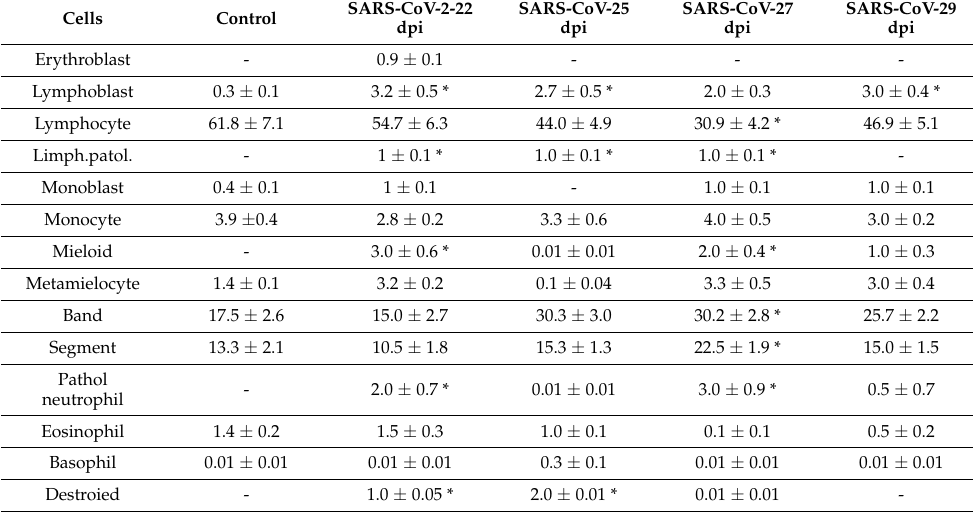
Table 2. Blood cells populations in norm and under the action of SARS CoV-2.